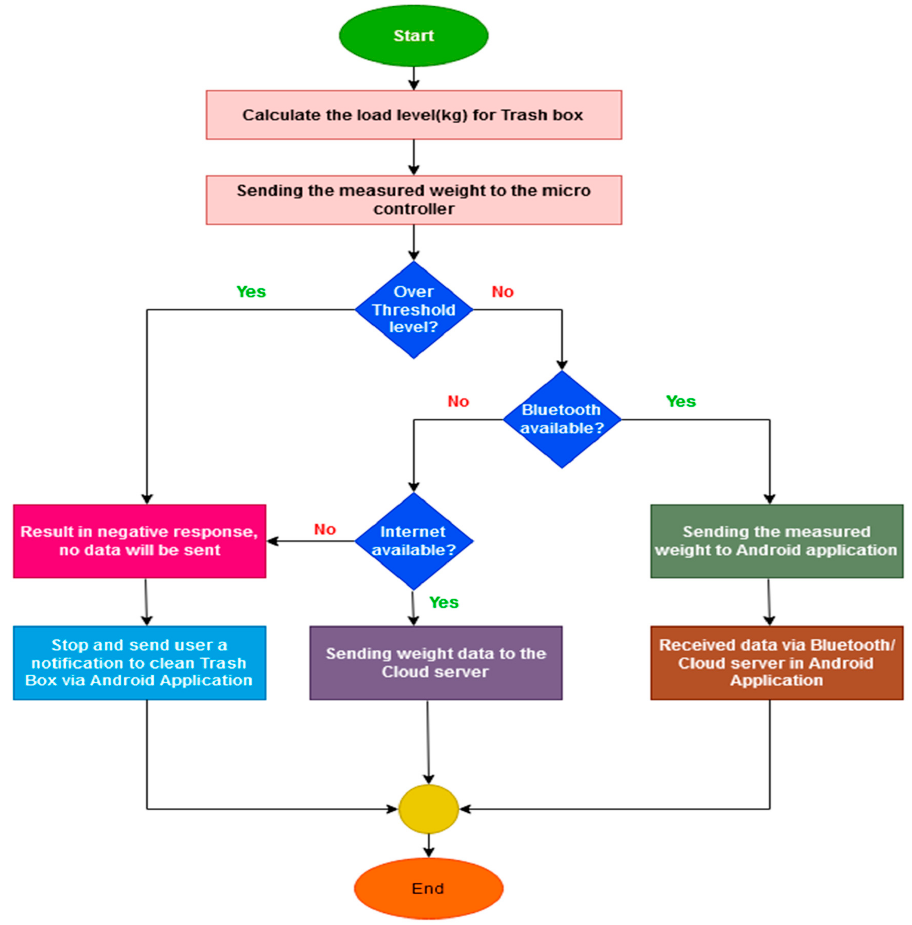
Figure 2. Flowchart of the proposed methodology.